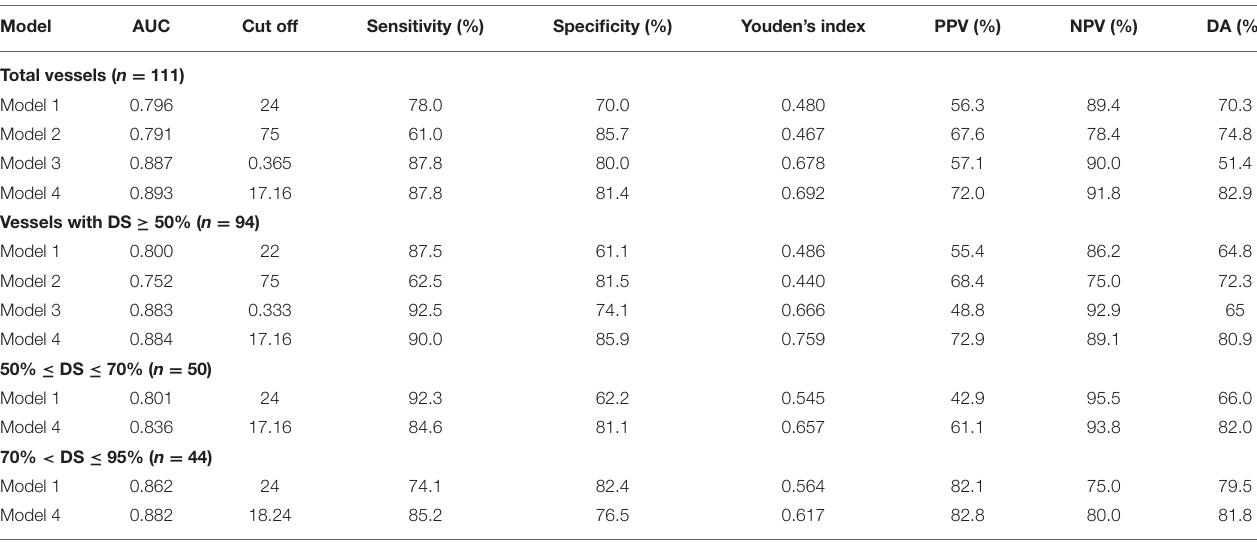
TABLE 5 | The results of ROC analysis in coronary arteries with positive and negative